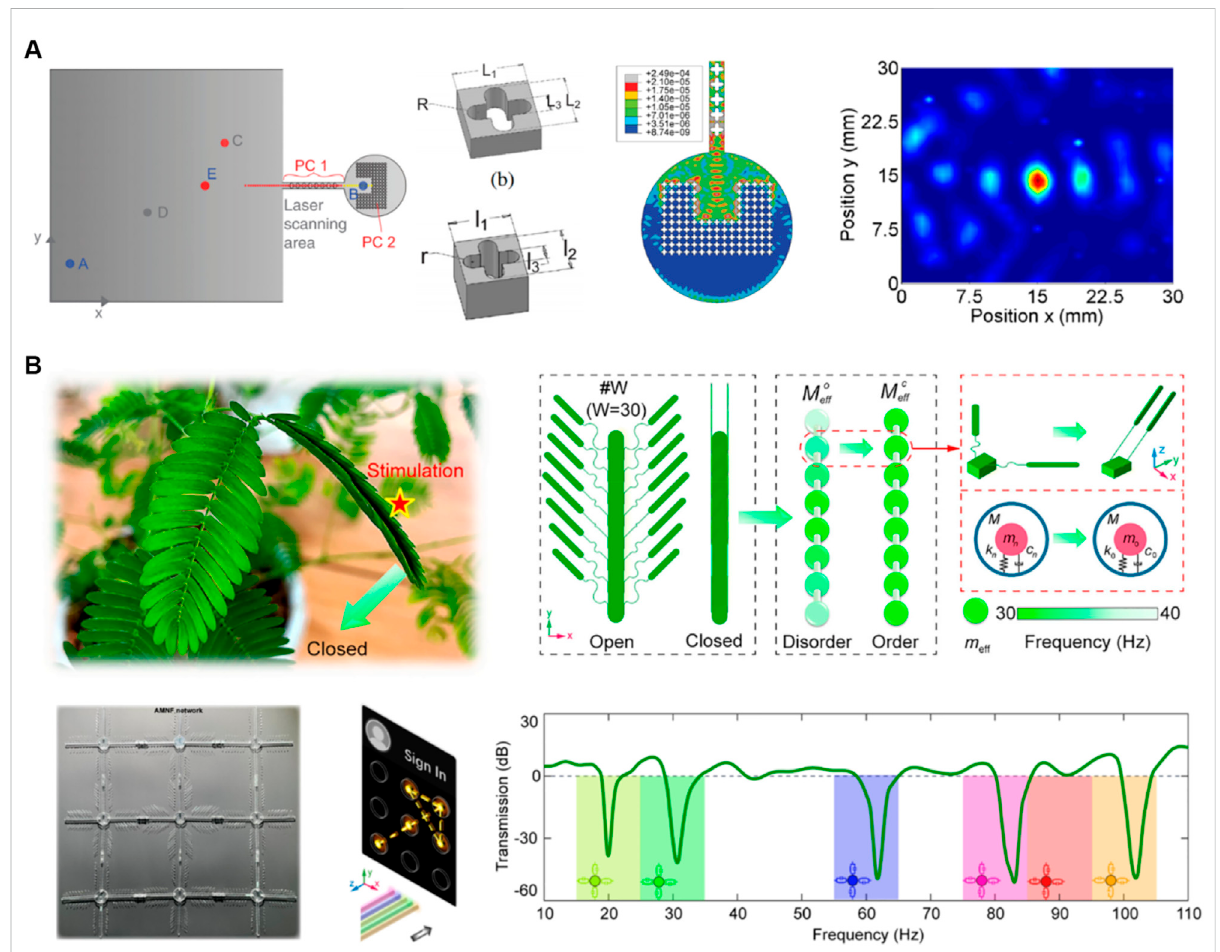
FIGURE 3 Elastic wave detection with metamaterials. (A) Proof of concept for an ultrasensitive technique to detect and localize sources of elastic nonlinearity using phononic crystals [74]. (B) Stimuli-responsive metamaterials with information-driven elastodynamics programming [72]. Figure reproduced with permission form: (A) , © 2017, American Physical Society; (B) , © 2021, Elsevier